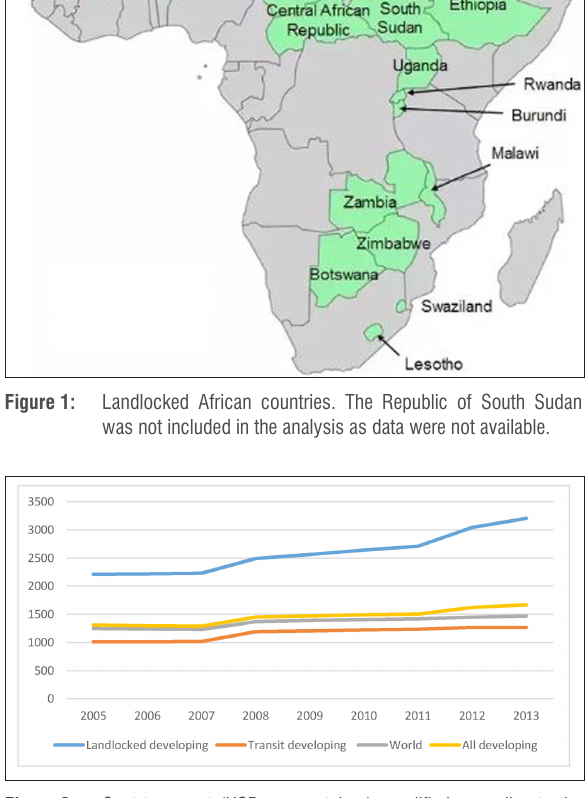
Figure 2: Cost to export (USD per container), modified according to the UN-OHRLLS 11 indicators.